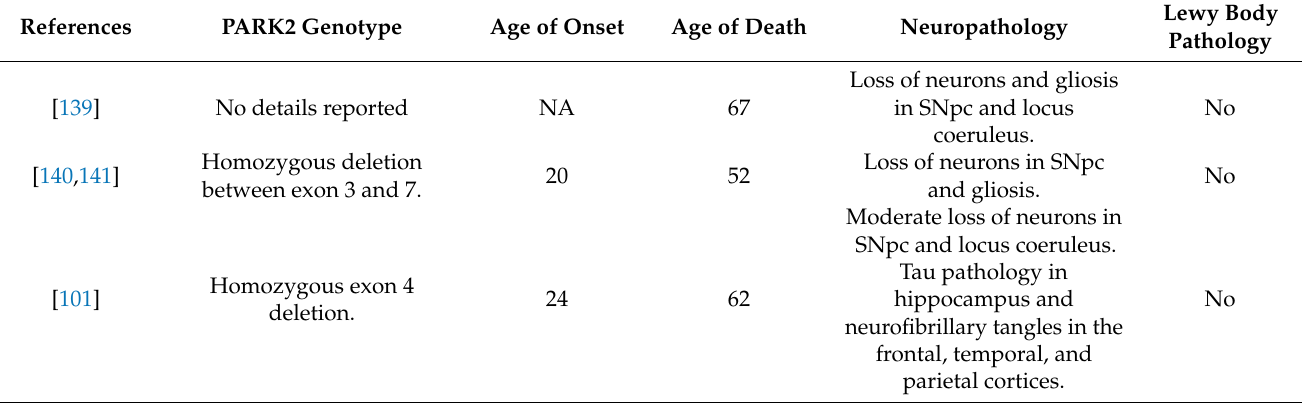
Table 2. Summary of post-mortem neuropathological findings from patients with various PARK2